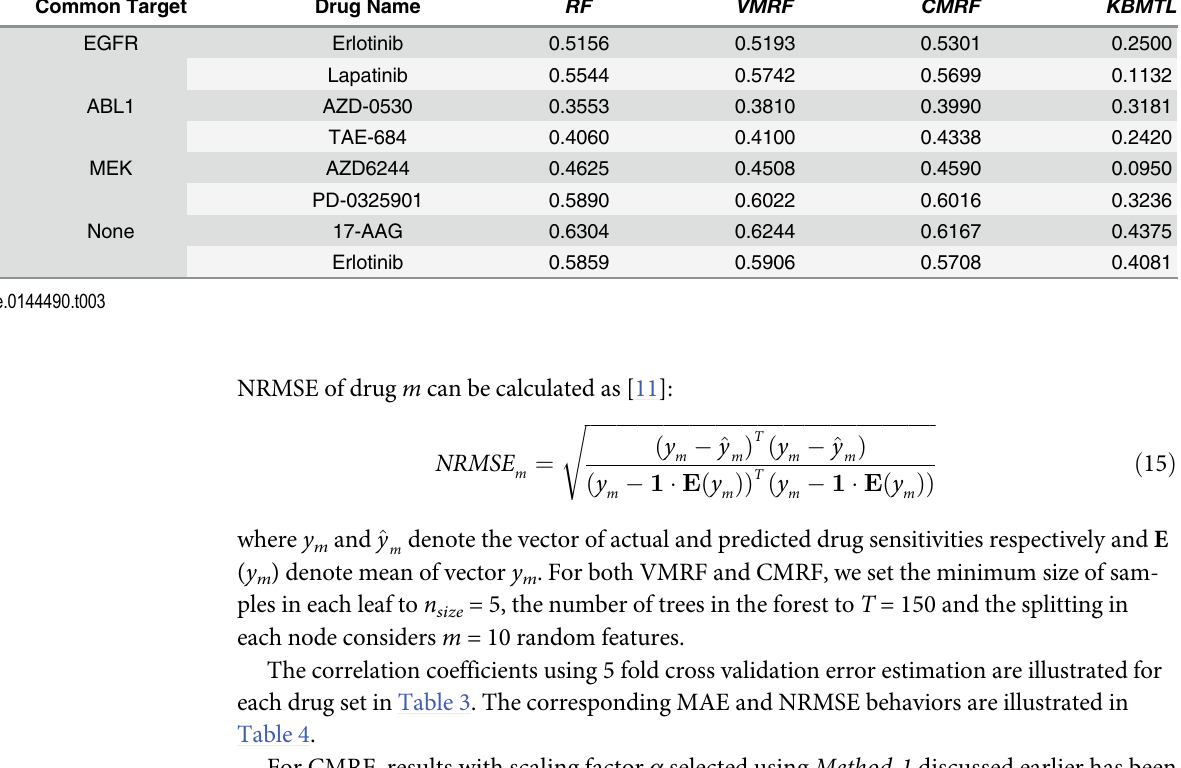
MAE NRMSE 0.8459 0.8486